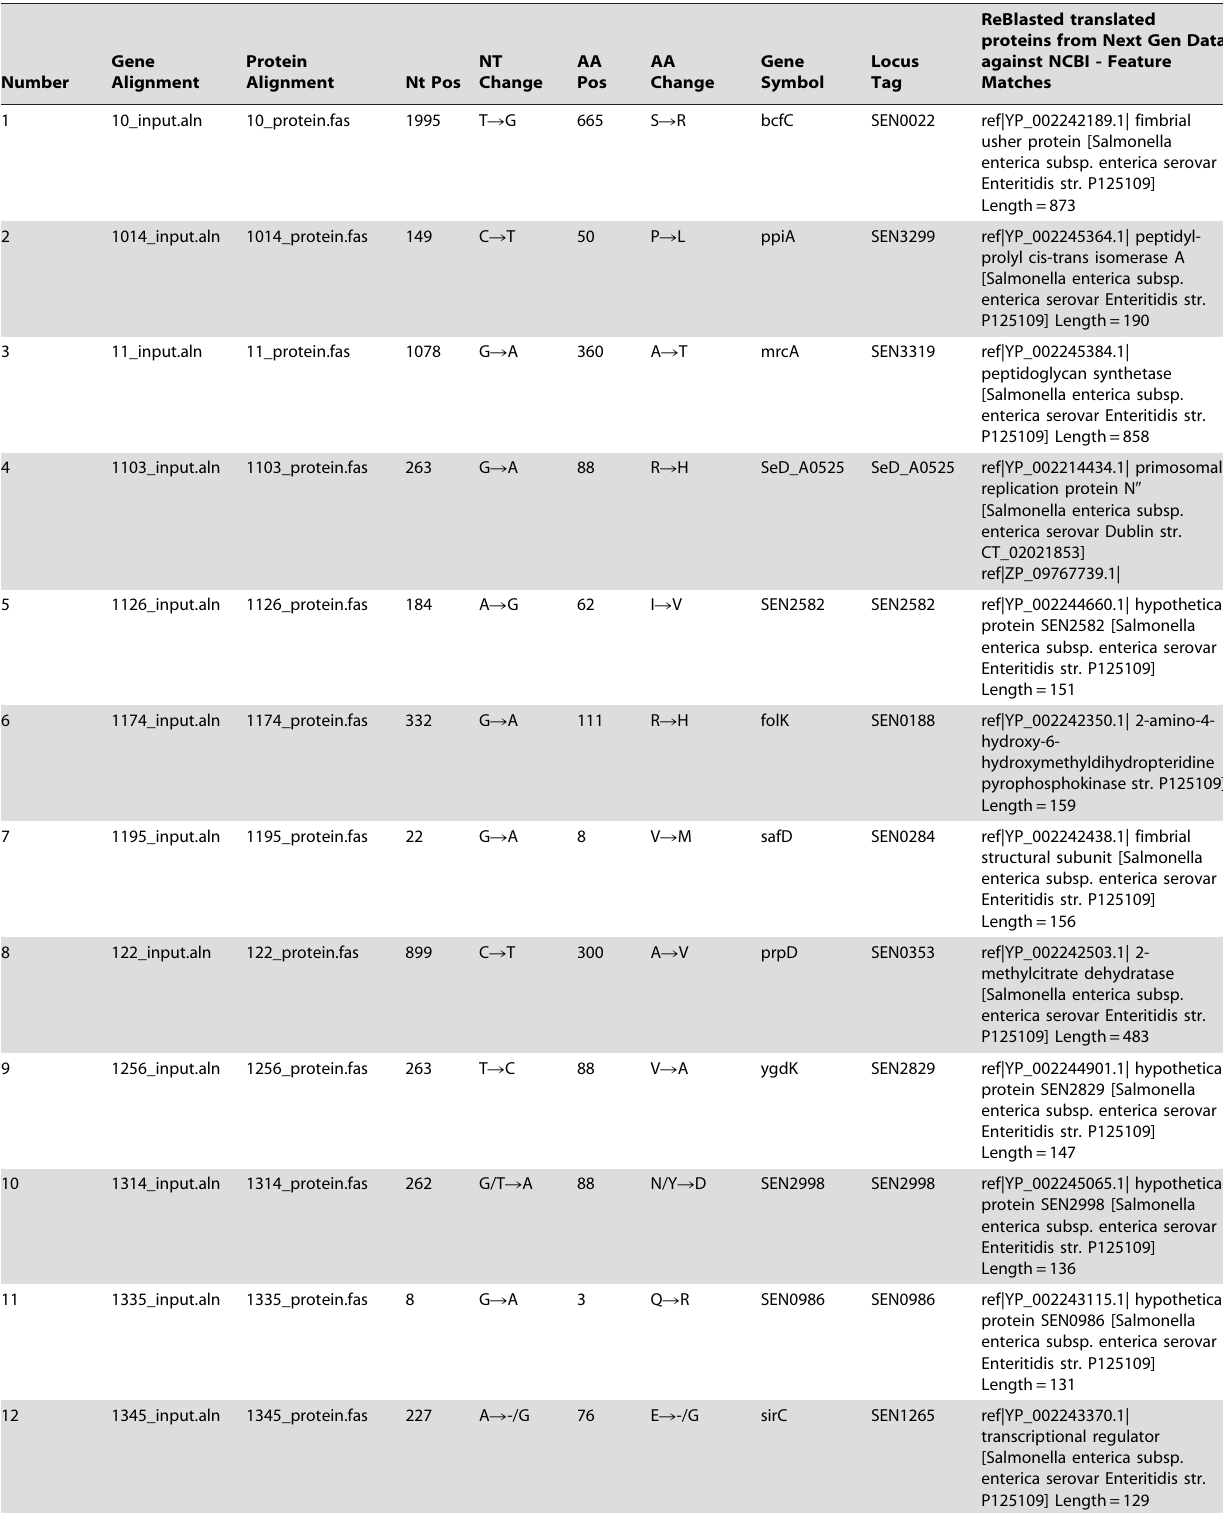
Variable genes observed that may define Salmonella